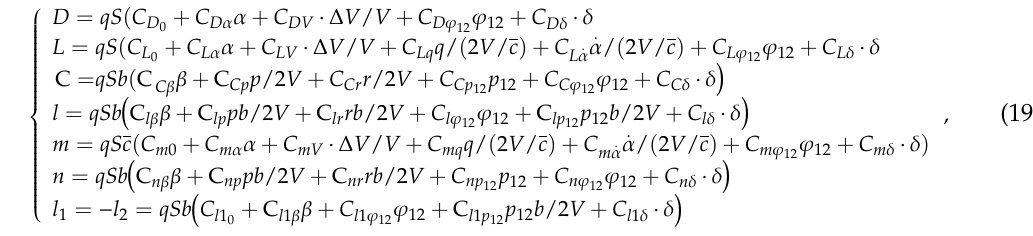
Figure 7. Wingtip-jointed aircraft system unstructured grid.